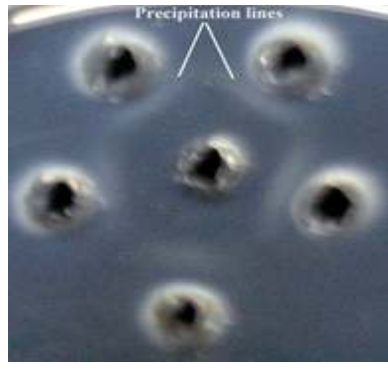
Figure-1. AGID assay, a portion of petri plate showing white precipitation line between cytoplasmic antigens of Map and antibodies from cattle